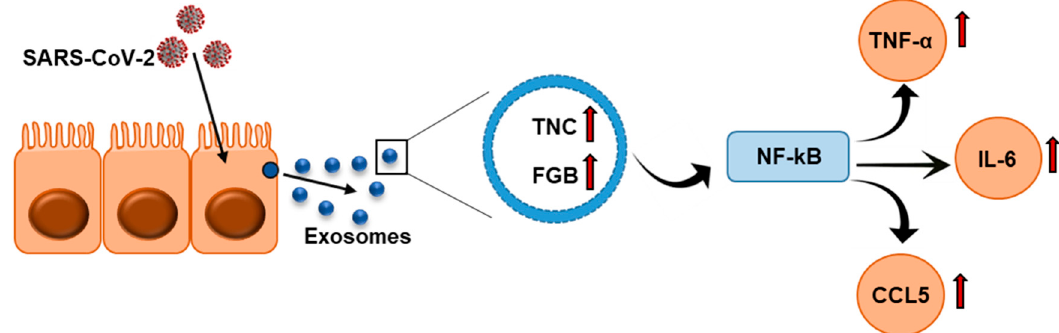
Figure 6. Schematic representation shows exosomes secreted from SARS-CoV-2-infected cells are enriched with TNC and FGB triggering TNF- α , IL-6, and CCL5 production in hepatocytes via NF- κ B signaling.